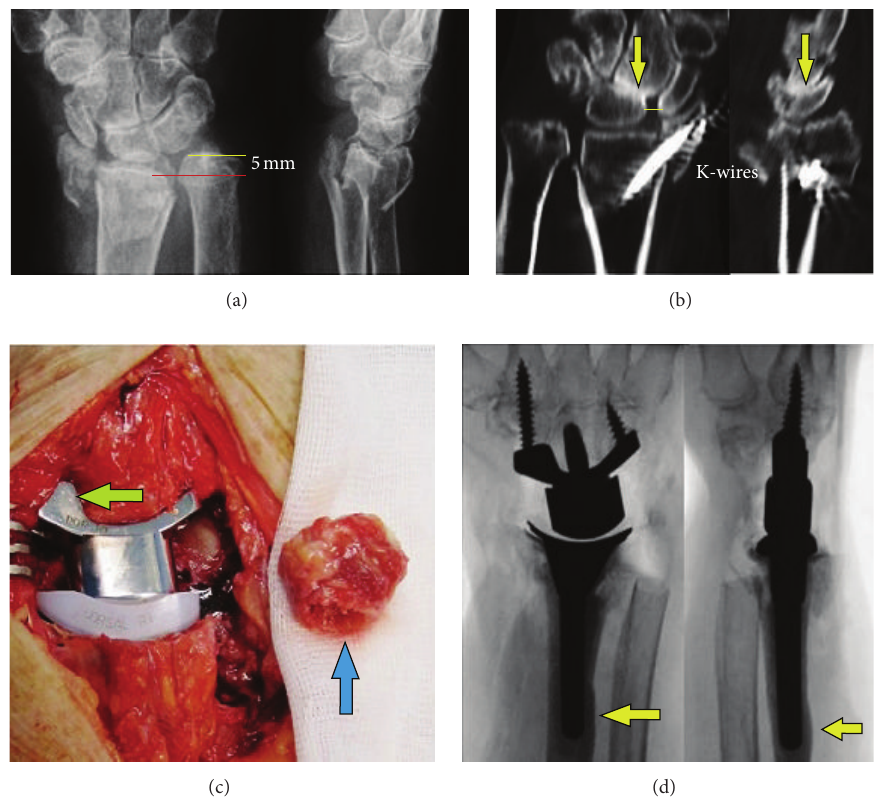
Figure 4: Case report 2 (preoperative and surgical procedures): (a) initial AP and lateral radiographs; (b) coronary and sagittal CT images after removal of external fixateur and percutaneous pinning demonstrating a step-off in the radial articular surface of 3 mm and widened scapholunate gap ( line ) with midcarpal OA ( arrow ); (c) intraoperative clinical photo after Maestro WRS insertion by using a scaphoid augment of the carpal component after complete scaphoid excision ( arrow ) and resected ulnar head ( arrow ); (d) intraoperative AP and lateral fluoroscopy showing correct position of implant and the leakage of cement from one fixateur pin-hole ( arrows